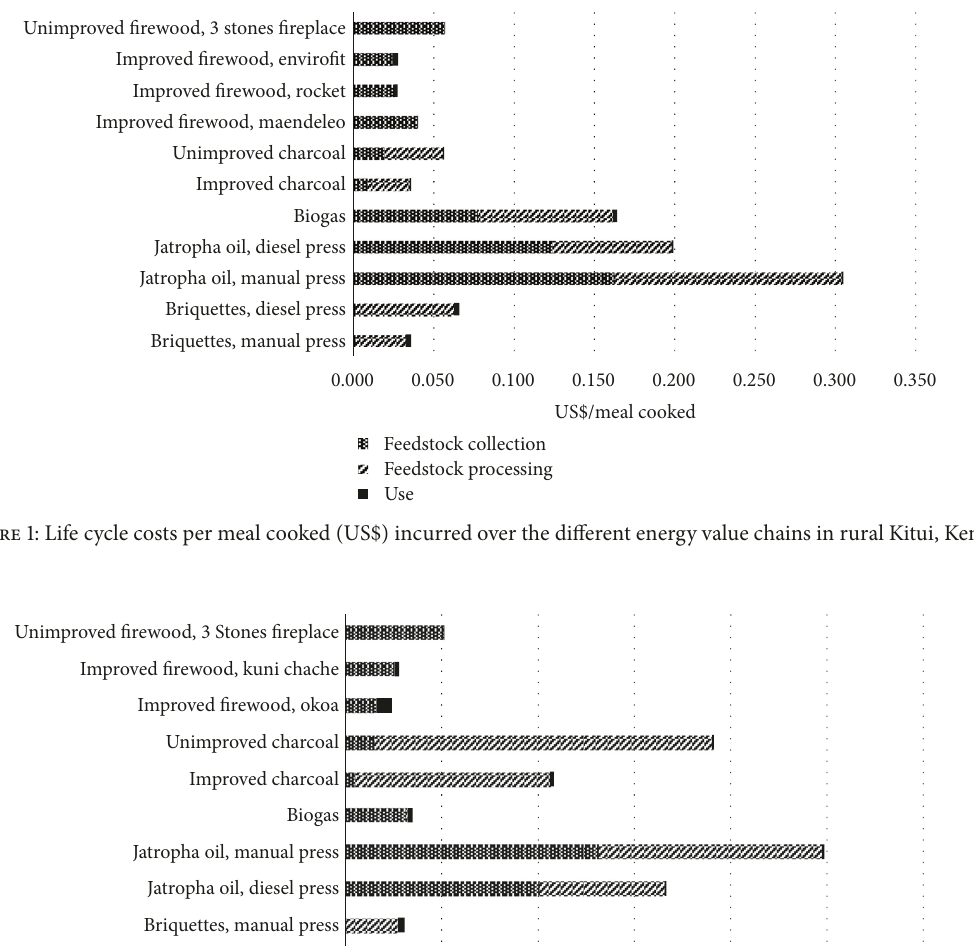
seeds is labour intensive, contributing up to 53% of the overall cost of jatropha oil manual value chain in Kitui and